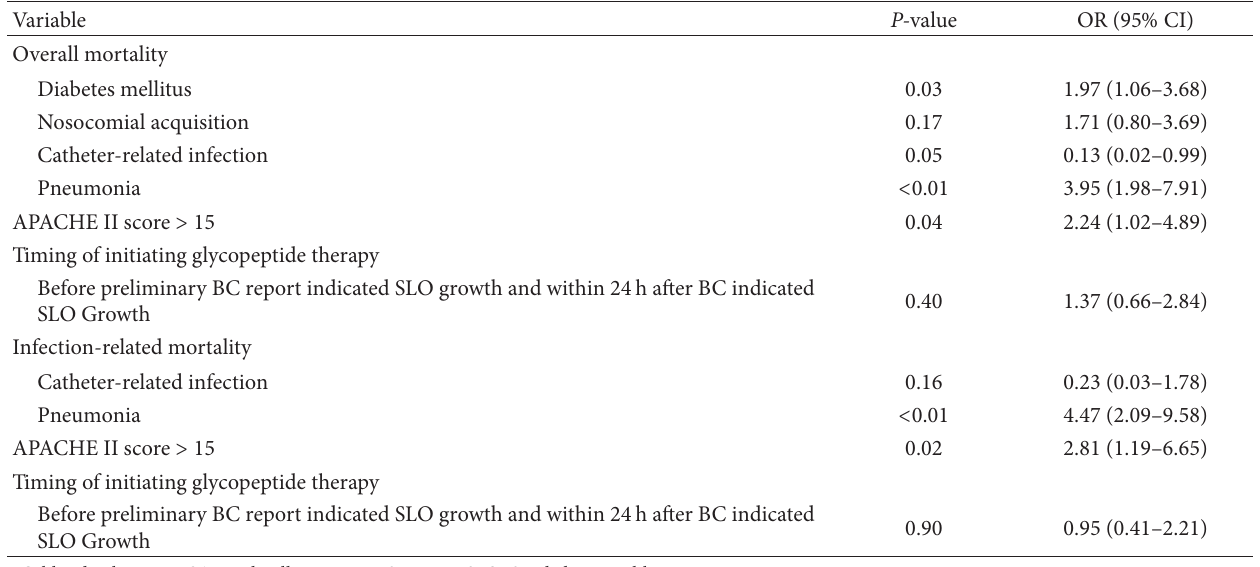
T 4: Multivariate analysis of risk factors for 14-day